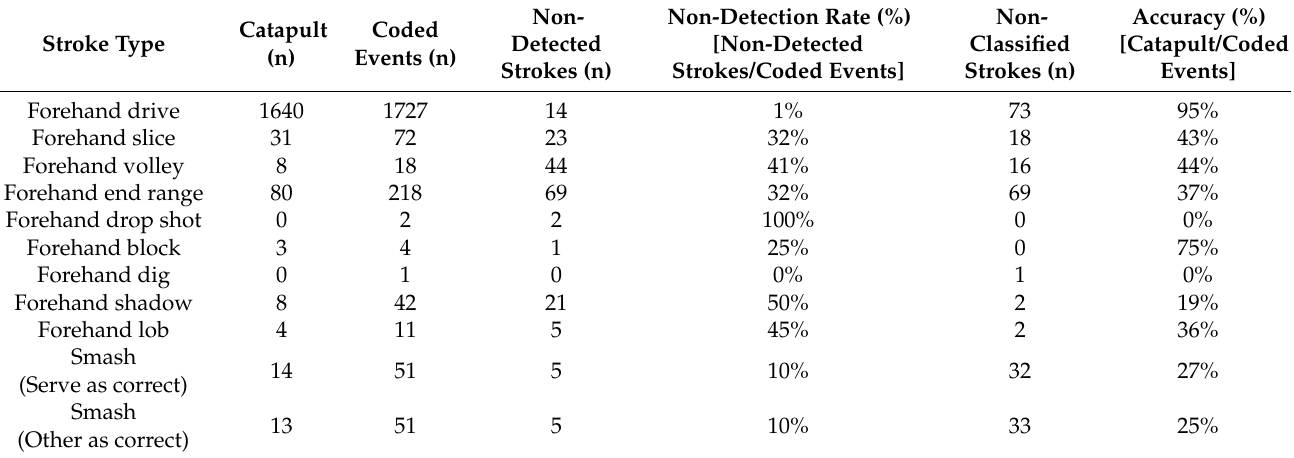
Table 3. Stroke-Level Analysis of Correctly Detected Catapult Forehand Strokes vs. Manual Coding